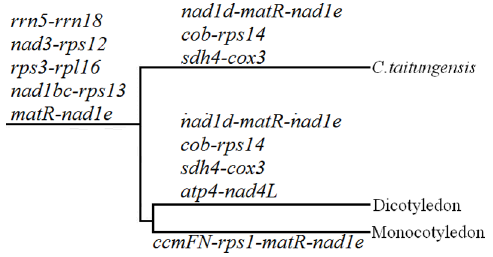
Figure 6. Distribution of conserved gene clusters.